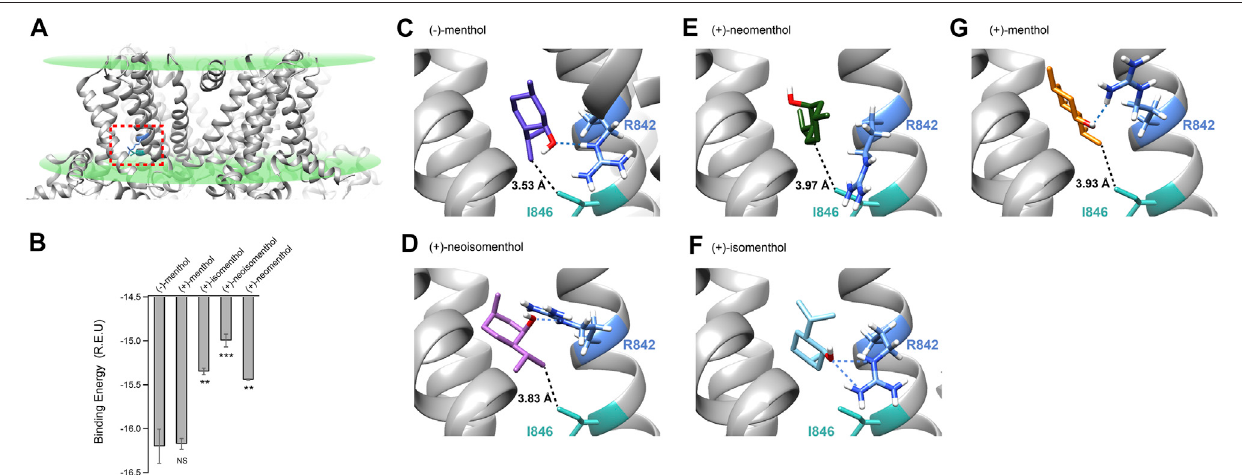
FIGURE 4 | Molecular docking suggested that menthol stereoisomers activated mouse TRPM8 in different binding con fi gurations. (A) Putative menthol-binding pocket located within the transmembrane domains of the TRPM8 channel as revealed by cryo-EM in apo state (PDB ID: 6BPQ). R842 and I846 are highlighted in blue and green, respectively. (B) Menthol stereoisomers were docked into the binding pocket. Averaged binding energy of the top ten binding models of each stereoisomer was measured. All statistical data are given as mean ± s.e.m. ( n = 10, two-sided t -test, * p < 0.05; ** p < 0.01; *** p < 0.001; **** p < 0.0001; NS, not statistically signi fi cant). (C – G) Docking of menthol stereoisomers into the binding pocket. The hydroxyl group of stereoisomers was predicted to form a hydrogen bond with sidechain R842 (dashed line in blue), and the distance of the isopropyl group with sidechain I846 is shown with dashed lines in